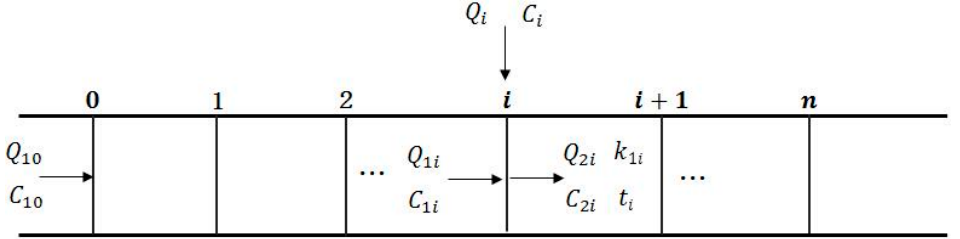
Figure 6. Schematic of conceptual model of one-dimensional steady-state river.